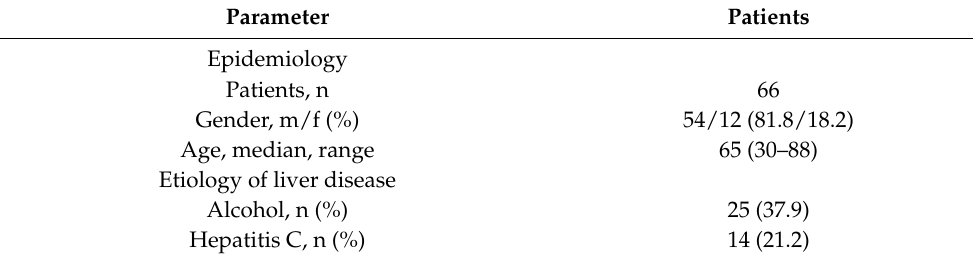
Table 1. Patient